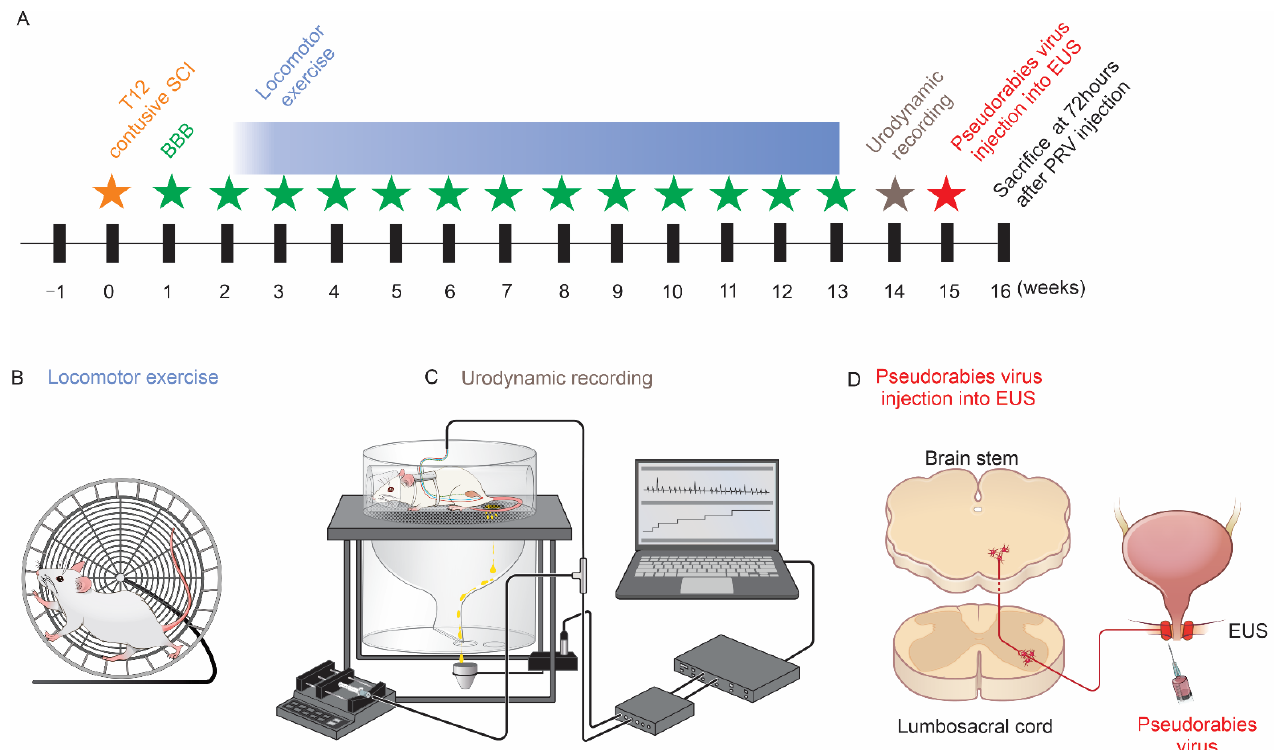
Figure 1. Study design diagram. ( A ) Experimental timeline and ( B ) cartoon figure of running wheel for rat exercise training after SCI. ( C ) Urodynamic recording (CMG and EMG) in an awake rat. The rat was kept in a customized restrainer. Sterile saline was instilled (0.1 mL/min) into the catheter connected with the bladder, and EUS EMG was recorded simultaneously. Voided saline was collected through the metabolic cage. ( D ) Pseudorabies virus injected into the EUS and trans-synaptically transported (retrograde) to the brainstem.